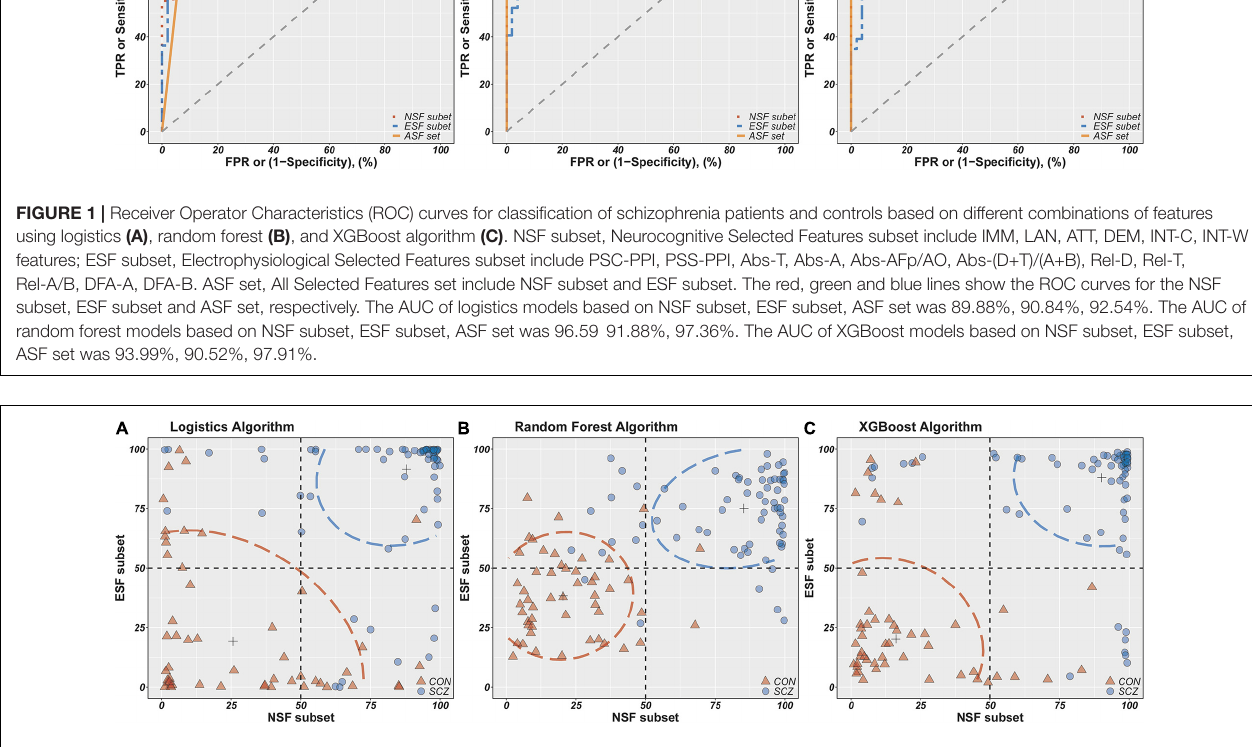
FIGURE 2 | The horizontal/longitudinal coordinate axis represents the probability of people with schizophrenia (%). NSF subset, Neurocognitive Selected Features subset include IMM, LAN, ATT, DEM, INT-C, INT-W features; ESF subset, Electrophysiological Selected Features subset include PSC-PPI, PSS-PPI, Abs-T, Abs-A, Abs-AFp/AO, Abs-(D + T)/(A + B), Rel-D, Rel-T, Rel-A/B, DFA-A, DFA-B; ASF set, All Selected Features set include NSF subset and ESF subset. (A–C) Scatter plots from two features set (NSF subset and ESF subset) using logistics, random forest and XGBoost